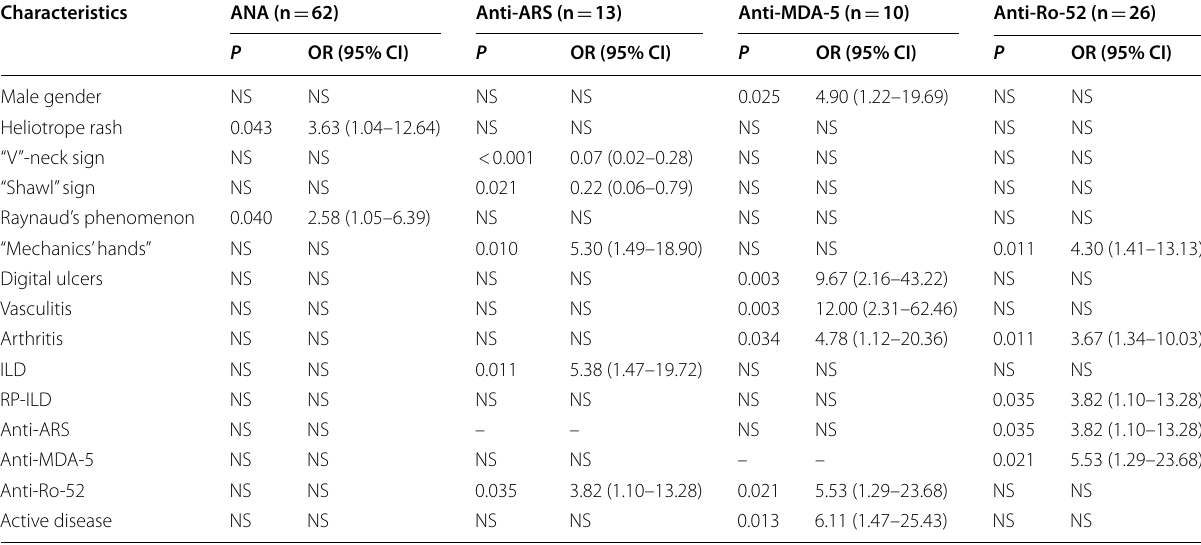
Table 5 Autoantibodies and their association with specific sets of clinical, imaging, and laboratory features of dermatomyositis using a univariate binary logistic